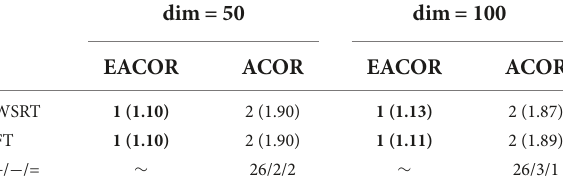
TABLE 5 Comparative results of stability analysis.